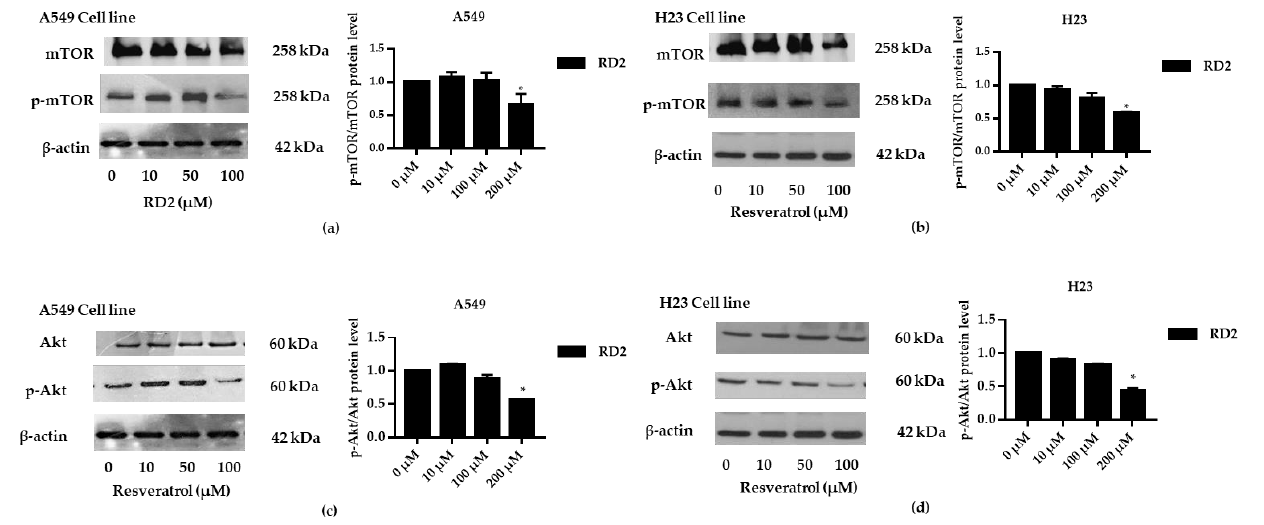
Table 1. The binding affinities of ligands docked with the ATP-binding site of Akt-1 .